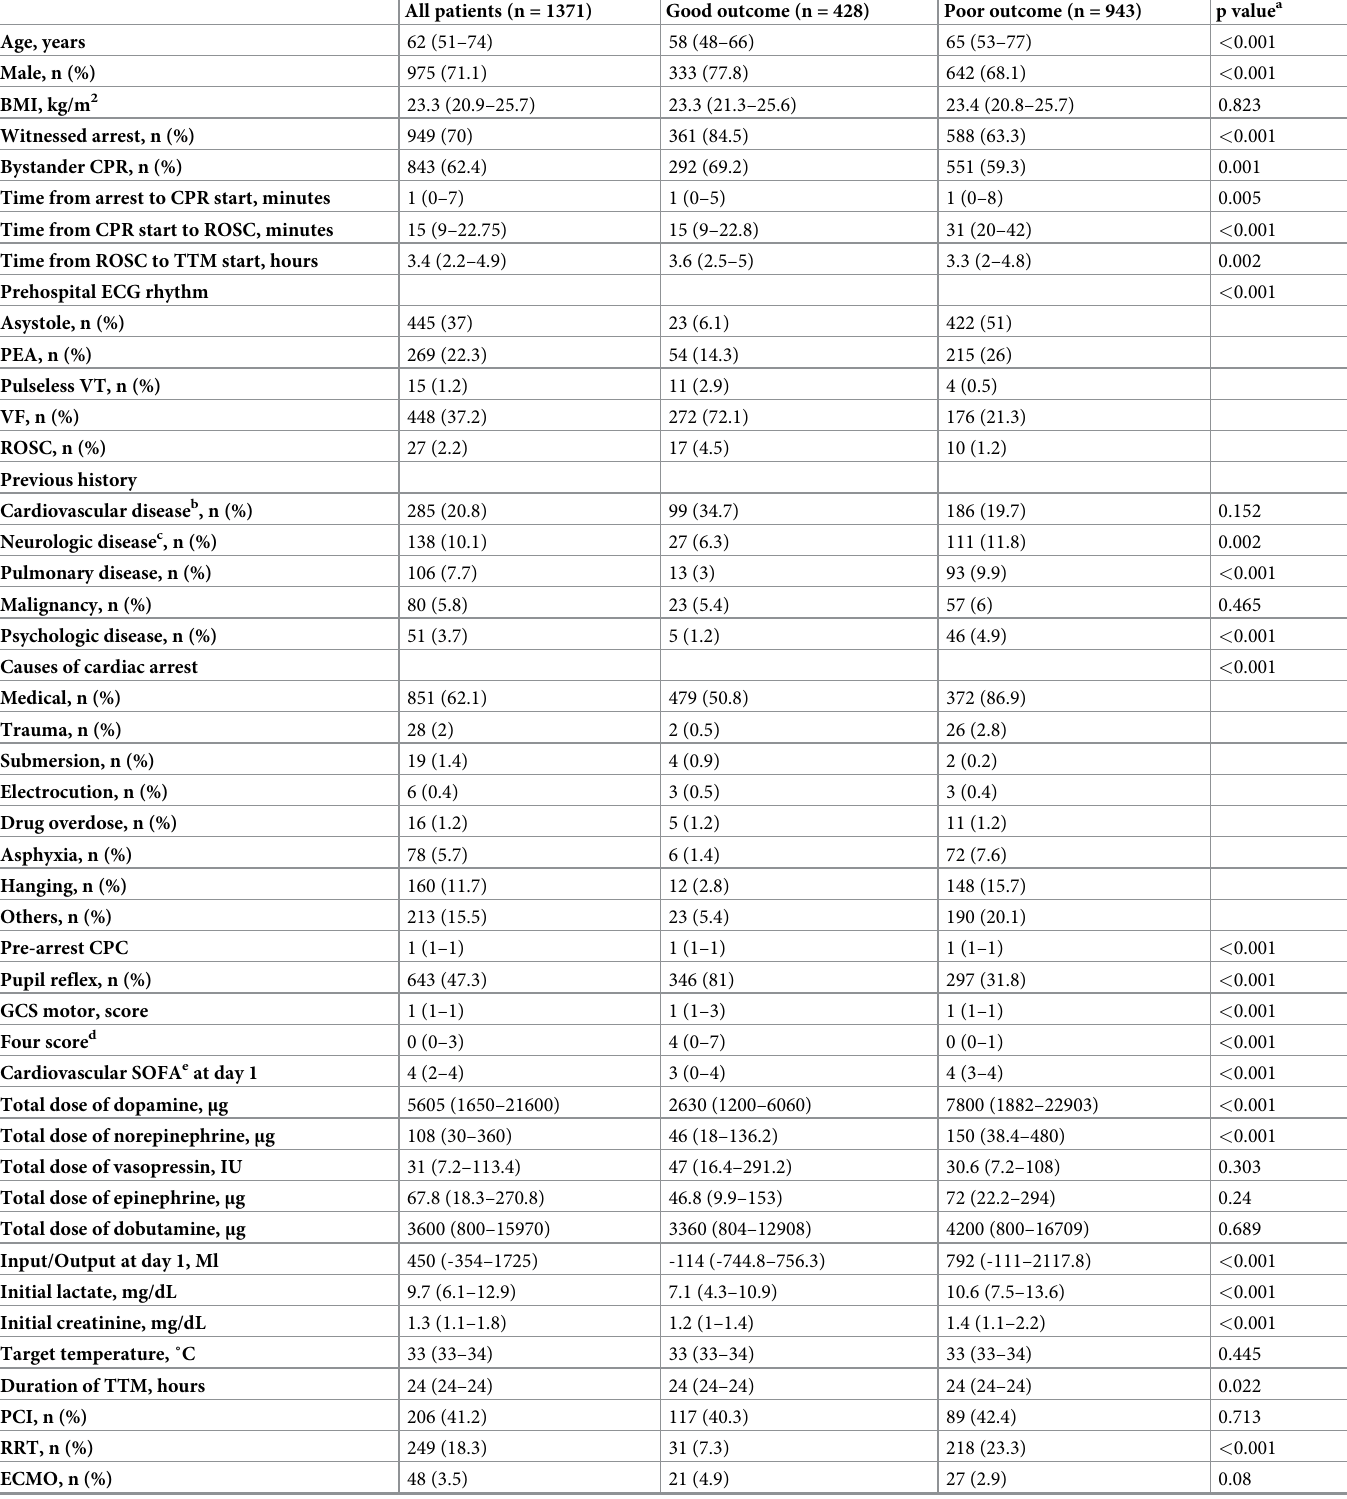
Table 1. Baseline